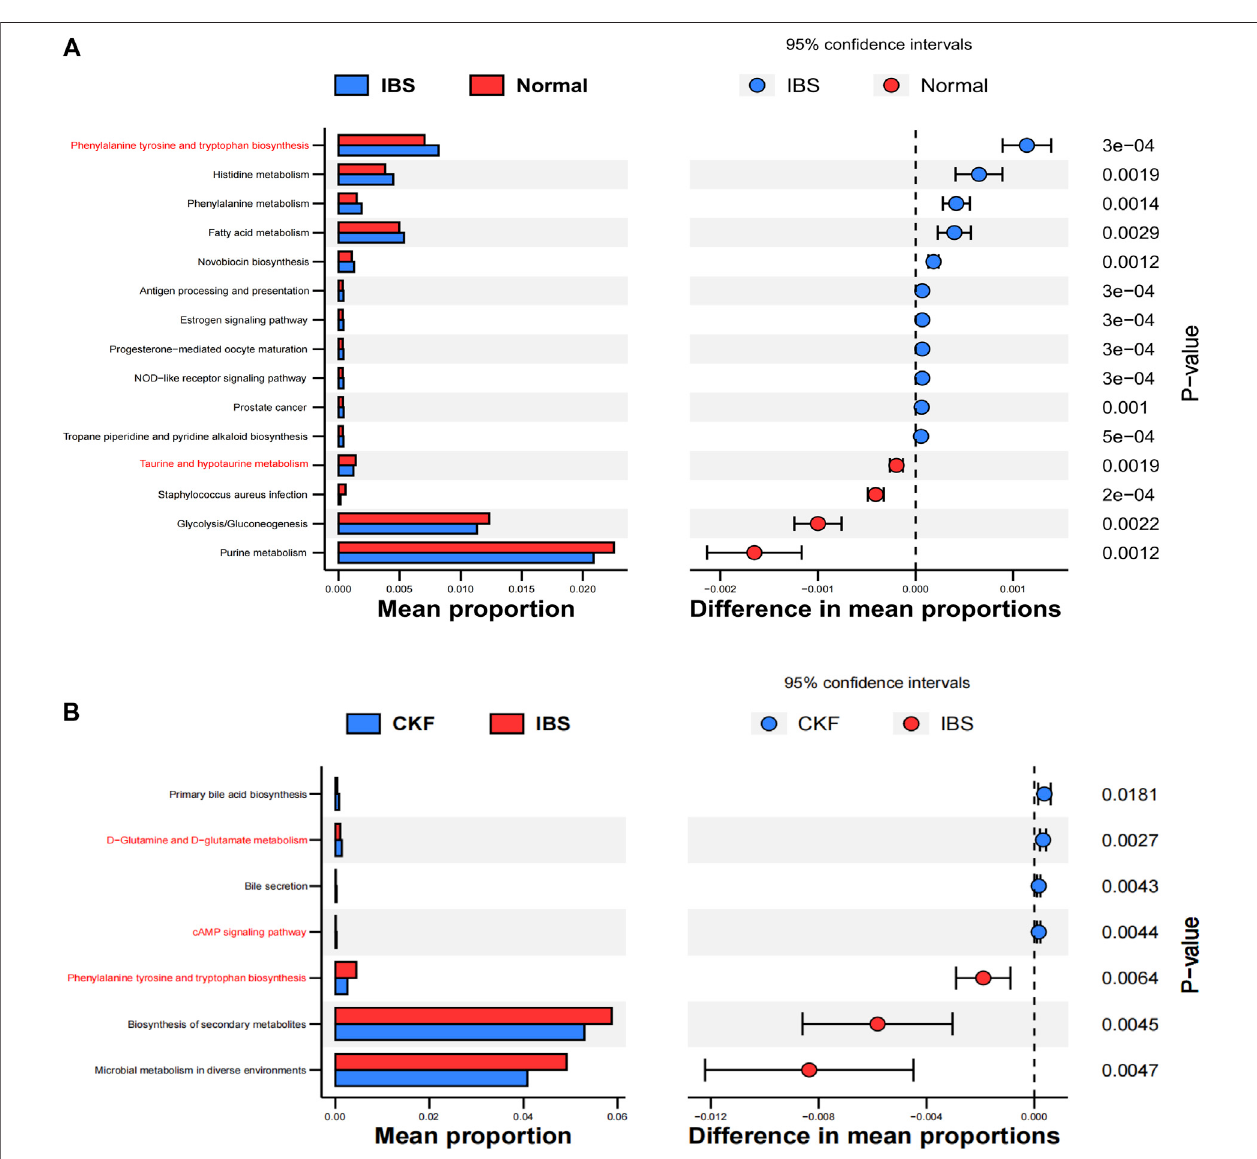
FIGURE 12 | Functional predictions for the altered gut microbiota. Differential KEGG pathways on comparing IBS vs. Normal groups (A) and CKF vs. IBS groups (B) .